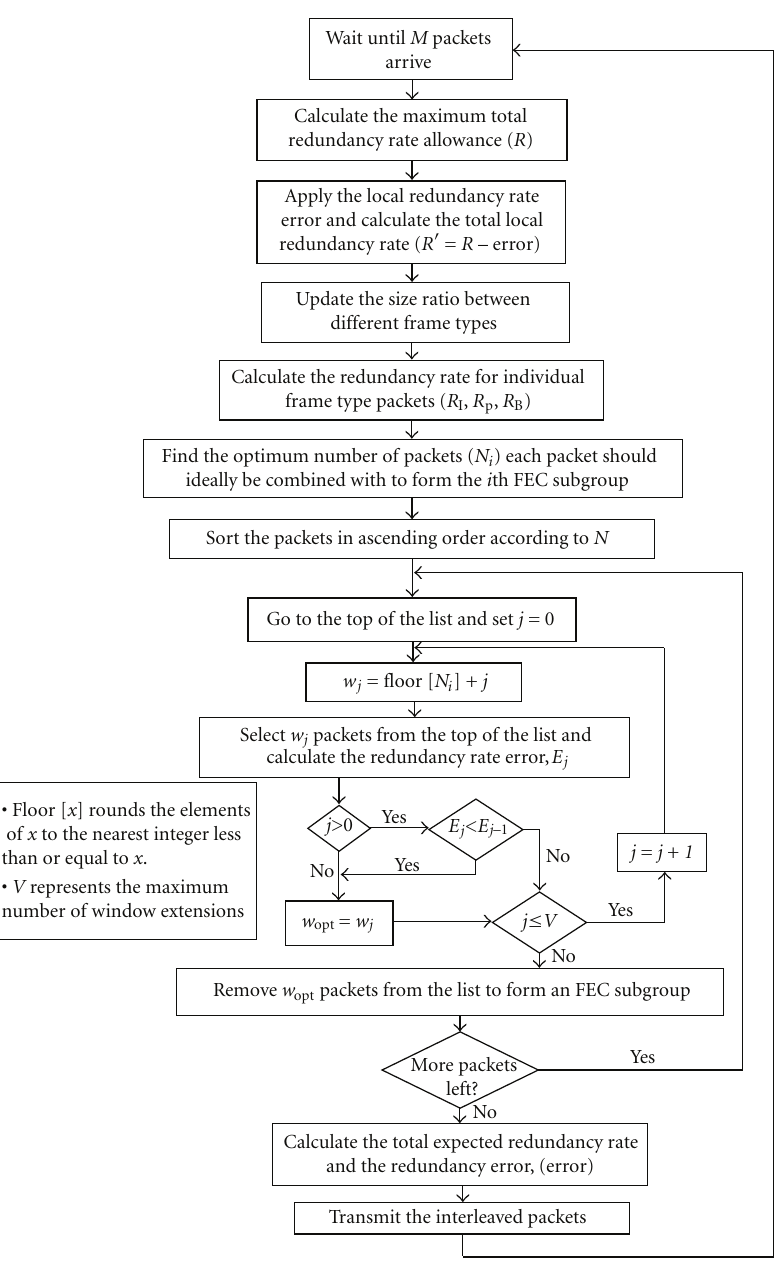
Figure 4: Algorithm for the formation of FEC